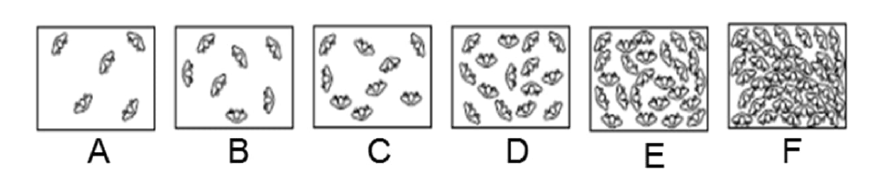
Figure 3. The LOS scale developed by Fruin and Benz (1984) contains 6 pictures illustrating 6 different density levels, starting with the least crowded (A) and increasing linearly to the last and most crowded (F). (Figure from Fruin and Benz